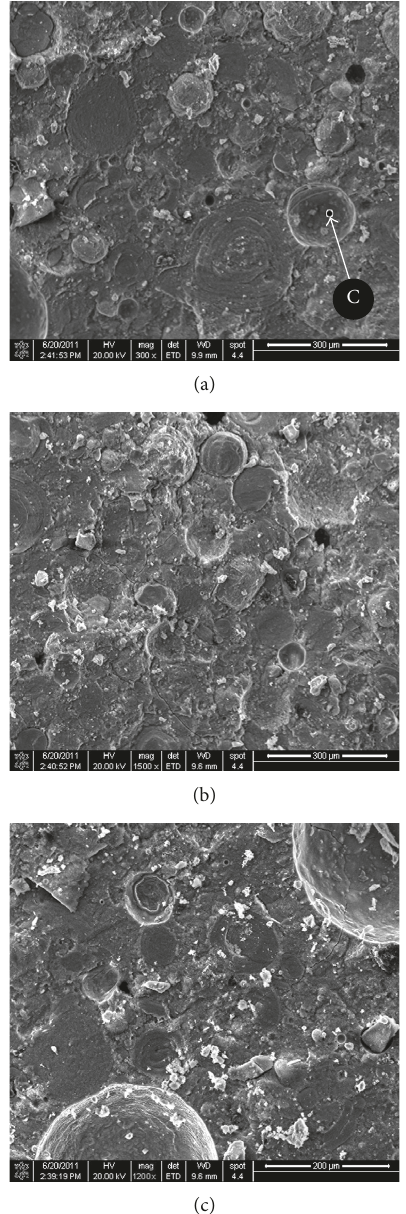
Figure 7: (a) Outer surfaces of sample SMF1 at 3 days (a), 30 days (b), and 60 days (c) from the end of heat curing.